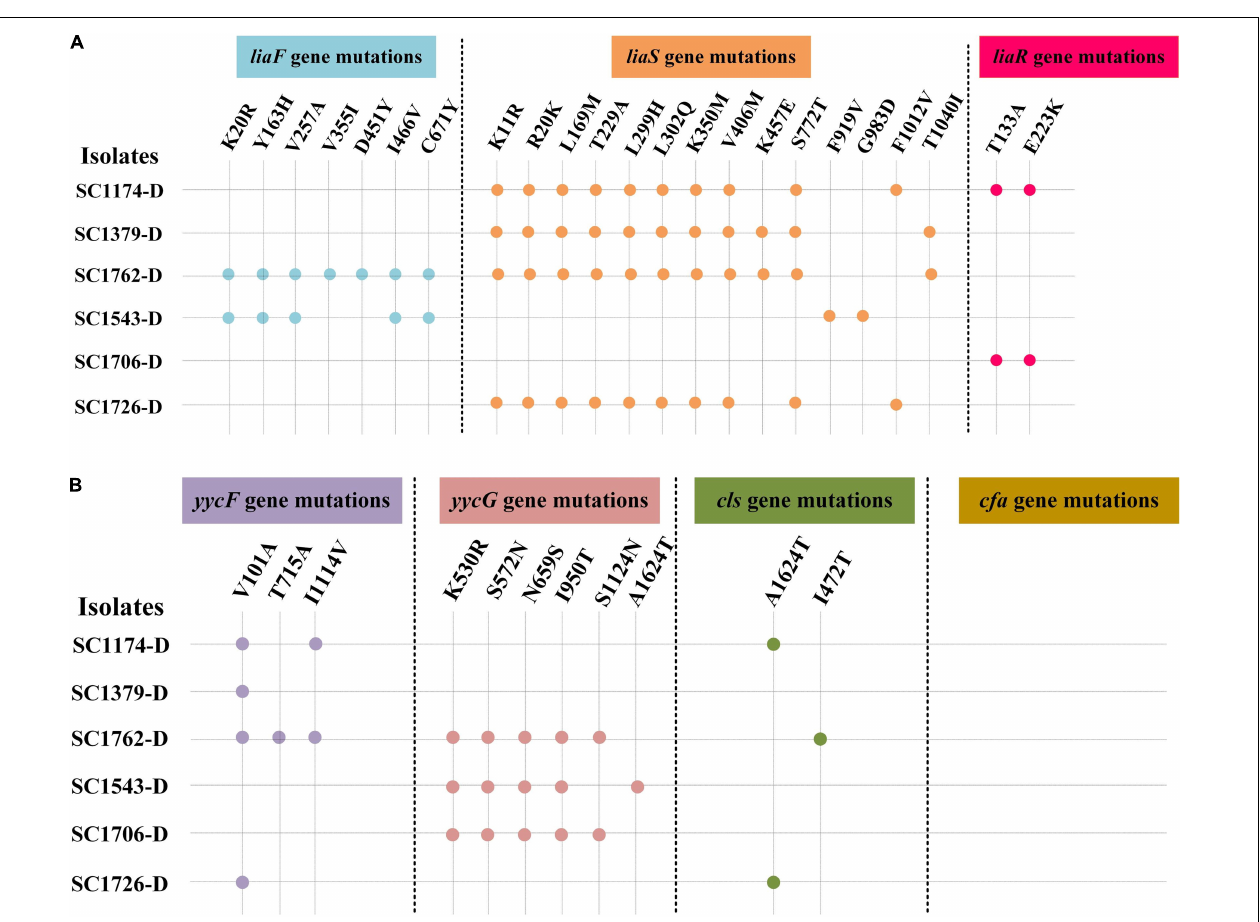
FIGURE 2 | Genes mutations in daptomycin-resistant mutants. DAP resistance gene mutations in the evolved DAP-R mutants. -D, evolved DAP-R isolates. (A) liaFSR gene mutations; (B) yycFG , cls , and cfa gene mutations. Blue, orange, red, purple, pink, and green dots represent the mutation sites in the liaF , liaS , liaR , yycF , yycG , and cls genes,